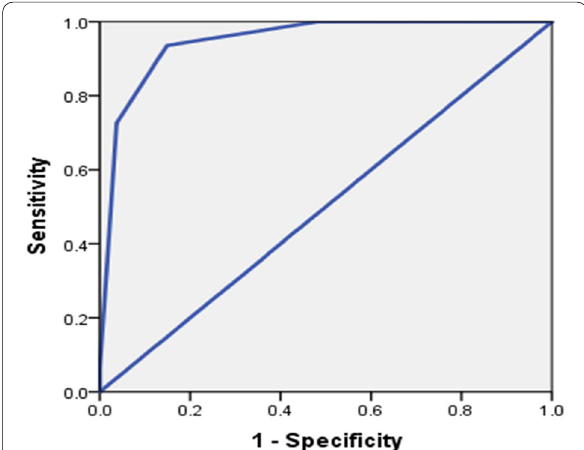
Fig. 2 Showing the ROC curve of the SLE score to discriminate against adverse pregnancy outcomes